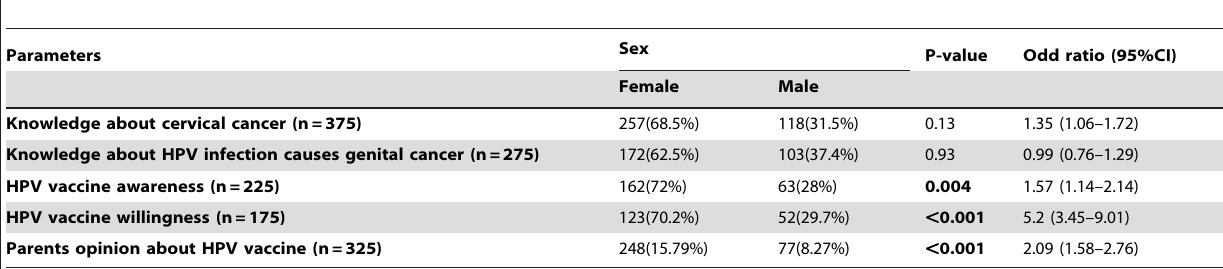
Table 3. Comparison of awareness among Females and Males.